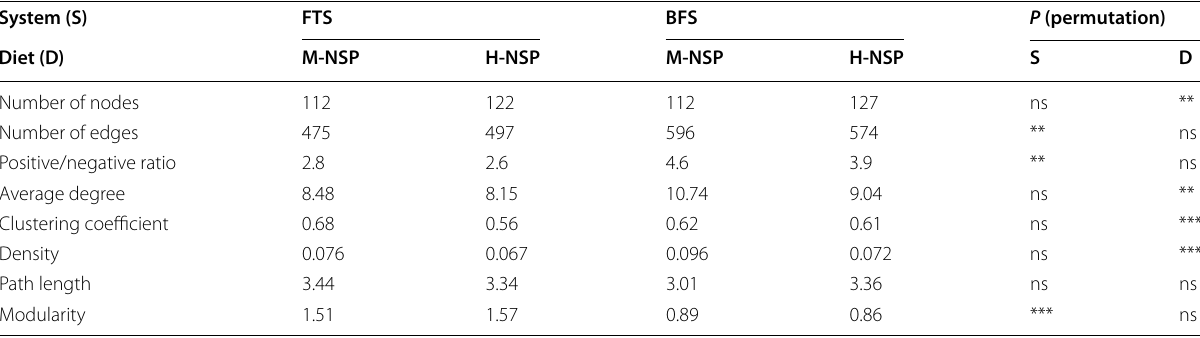
P values were calculated using Mann–Whitney test, after permutation of 70% of the initial data FTS flow-through system, BFS biofloc system, M-NSP moderate NSP diet, H-NSP high NSP diet, S larval rearing system in Phase I, D diet type in Phase III, ns not